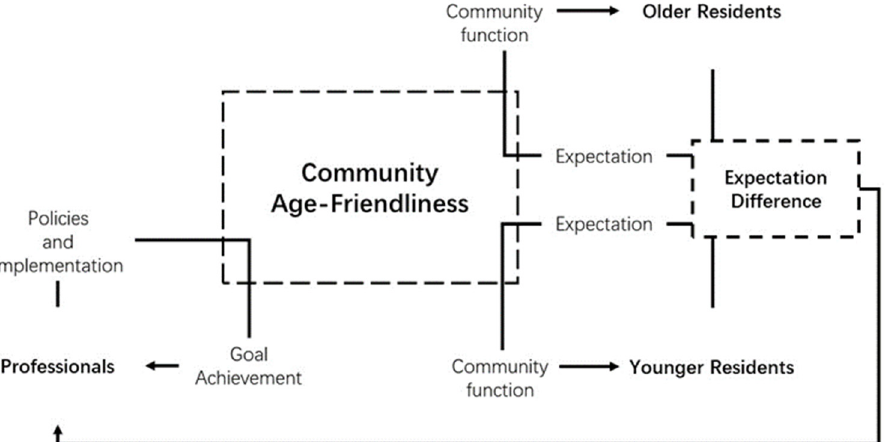
Figure 5. Life-cycle of community